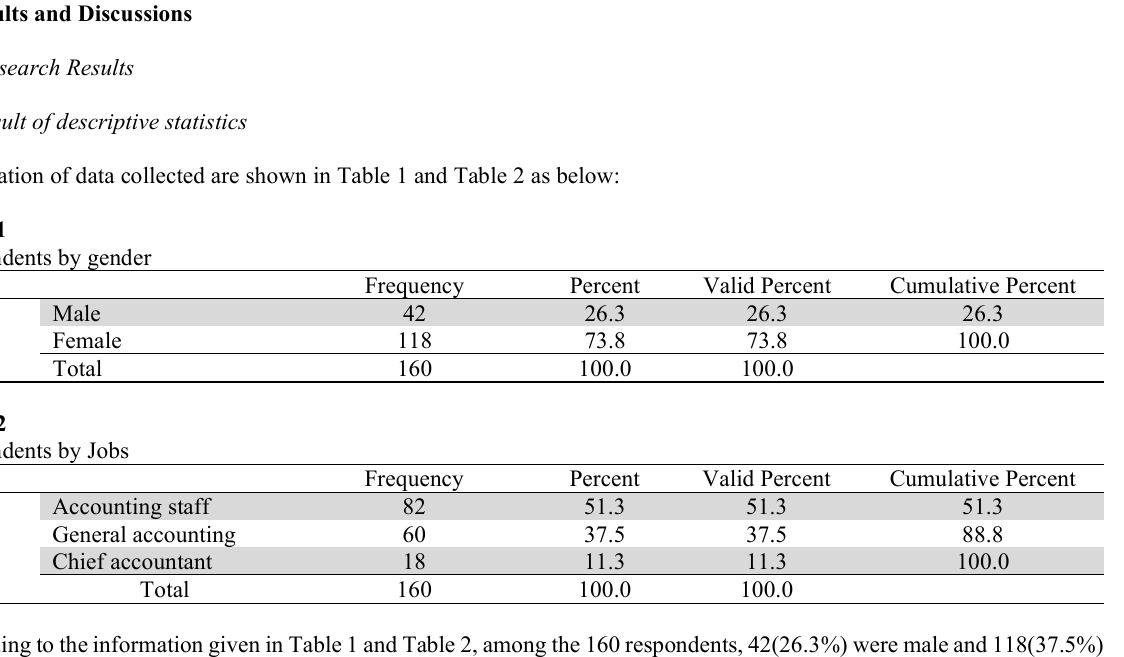
Results of analysis of Determinants Confidence of Scales in the Model Determinants n Cronbach’s Tangibles (T) Effectiveness (E) Empathy